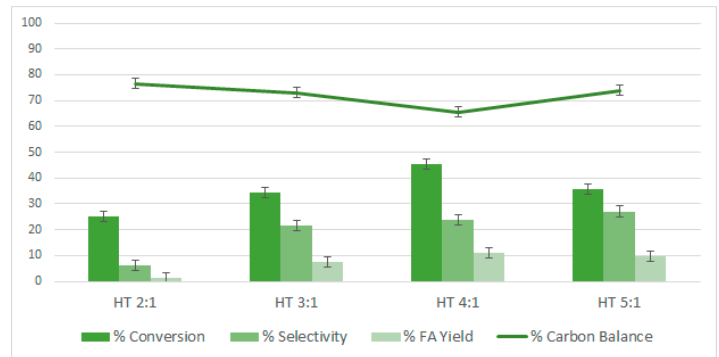
Figure 5. Comparison of the performance in furfural oxidation of HT supports with different molar Mg: Al ratios. Batch reactor, p = 6 bar (O 2 ), t = 110 °C, 2 h, stirring rate 600 rpm, [FF] = 26 mM, 100 mg Mg: Al ratios. Batch reactor, p = 6 bar (O 2 ), t = 110 ◦ C, 2 h, stirring rate 600 rpm, [FF] = 26 mM, 100 mg of HT. of HT.